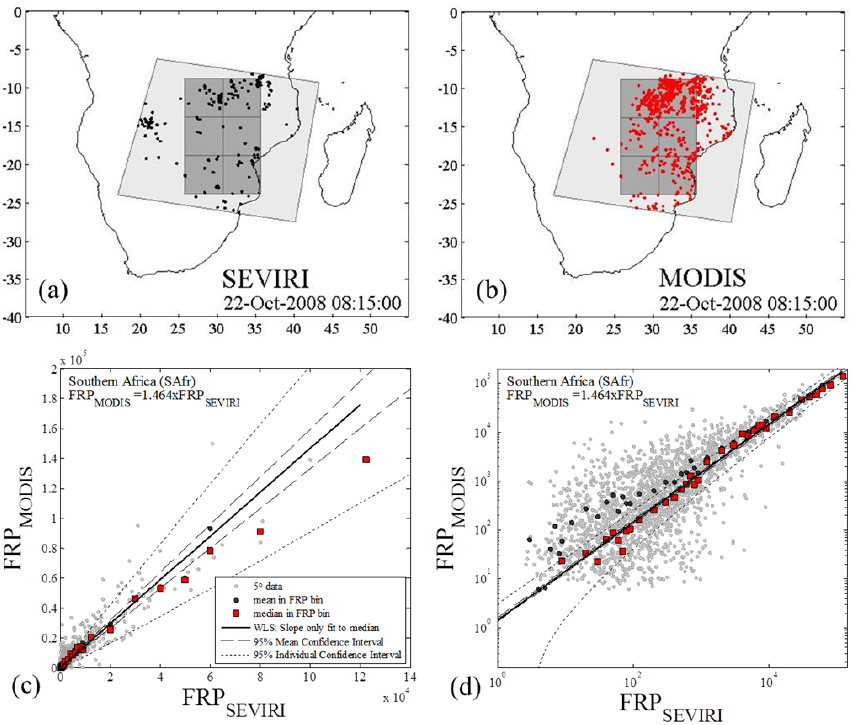
Figure 17. Illustration of the training data set and technique used to derive the regional bias adjustment factors used in generating the FRP- GRID product, here illustrated for the Southern African LSA SAF region. Temporally coincident (a) SEVIRI and (b) MODIS active fire pixels between May 2008 and May 2009 were accumulated in 5 ◦ grid cells strategically located within geographic areas covered by the centre two-thirds of the MODIS swath. Shown is one example obtained at 08:15UTC on 22 October 2008. To achieve a sufficient sample size, SEVIRI active fire pixels in 5 ◦ cells were averaged over an hour, as in the FRP-GRID product. These hourly values (grey circles) were binned and the result compared to the median (red squares) and mean (black circles) of the MODIS observations. Appropriate SEVIRI-to- MODIS bias adjustment coefficients were determined by performing a weighted linear least squares fit through the median values, shown in (c) on a linear scale and in (d) on a log scale (here for the SAfr region only). The resulting factors are applied in the FRP-GRID processing